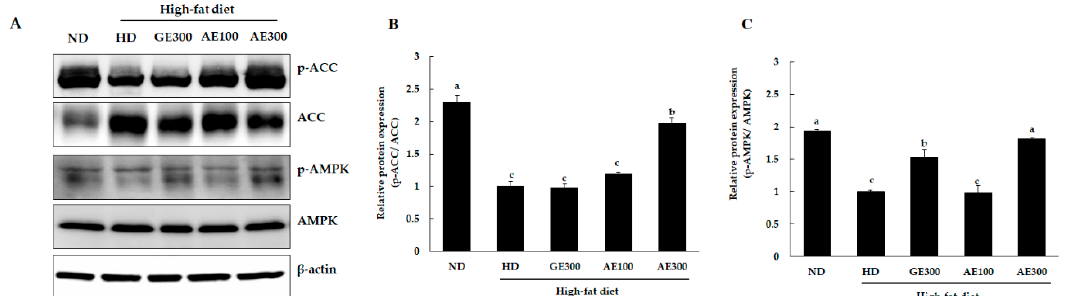
Figure 5. E ff ect of AE on proteins involved in lipid metabolism in the adipose tissue of the experimental mice. Mice were fed as previously indicated. ACC, acetyl-CoA carboxylase, p-ACC, phosphorylated ACC, AMPK, adenosine monophosphate (AMP)-activated protein kinase, p-AMPK, phosphorylated AMPK. ( A ) Western blot, ( B ) relative expression of p-ACC, and ( C ) relative expression of p-AMPK. Values are expressed as mean ± SEM of four separate experiments. ND, normal diet, HD, high-fat diet, GE300, high-fat diet + Garcinia 300 mg / kg b.w, AE100, high-fat diet + 100 mg / kg b.w, AE300, high-fat diet + 300 mg / kg b.w. The varying superscript letters indicate a statistically significant di ff erence among the groups by Duncan’s test of ANOVA, p < 0.05.